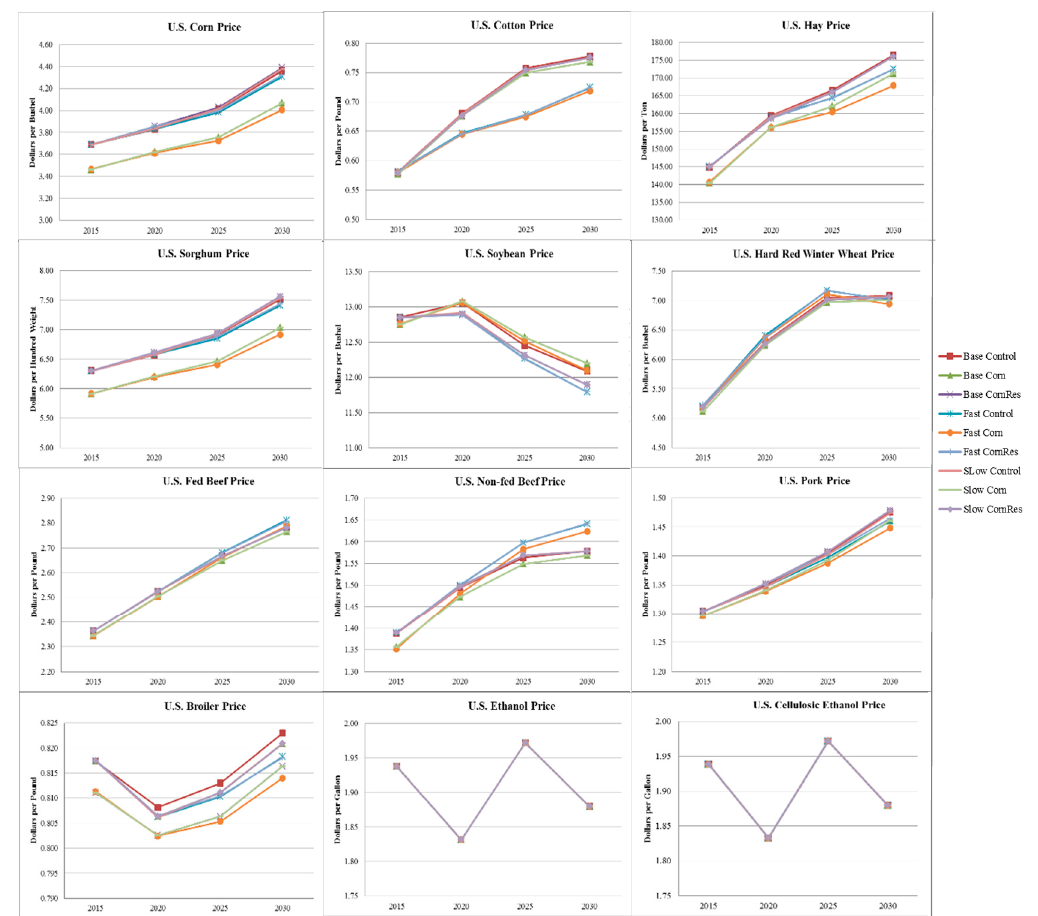
Figure 6. Average U.S. commodity price projection during 2015 to 2030.